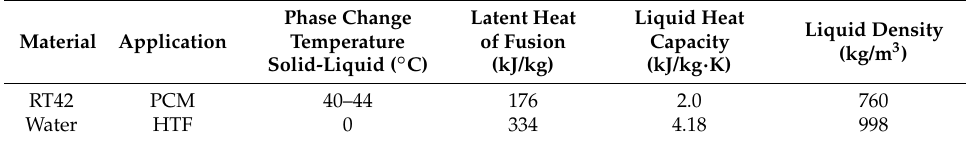
Table 1. Properties of applied